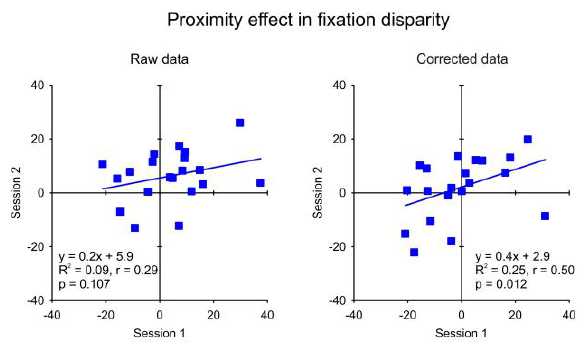
Figure 6: For the raw fixation disparity and the corrected fixation disparity it is shown the test-retest correlation between the changes in fixation disparity (min arc) per change in vergence stimulus (1/meter=meter angle) when varying the viewing distance (40, 30, and 24 cm), i. e. the proximity effect. Because of outliers, robust correlations were